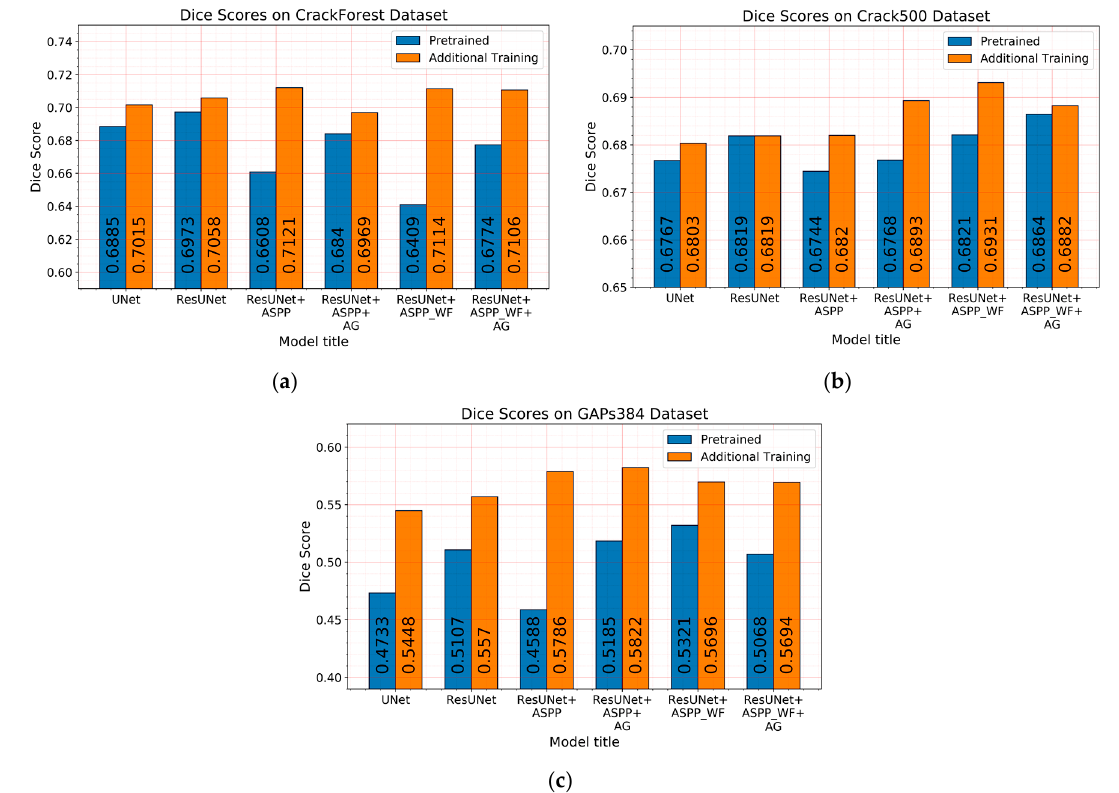
Figure 12. Dice score of every model trained with the mixed dataset (blue bars) and after being trained with a specific dataset (orange bars): ( a ) CrackForest, ( b) Crack500, (c) GAPs384